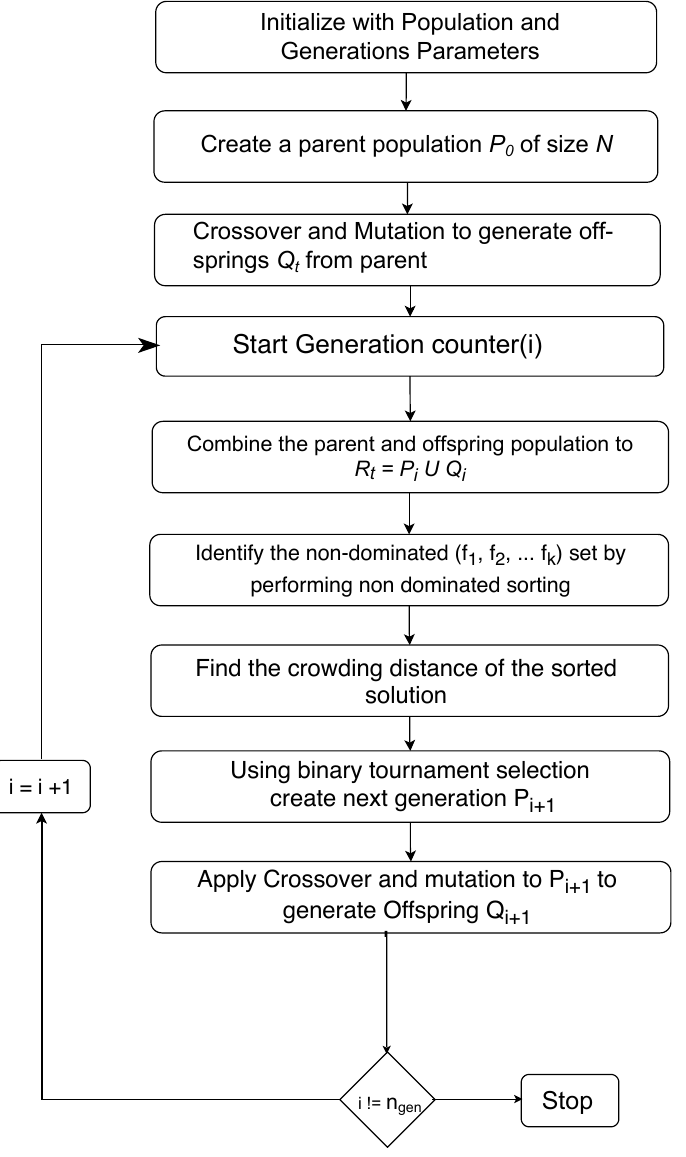
Figure 5. Procedure for the NSGA-2 algorithm implementation